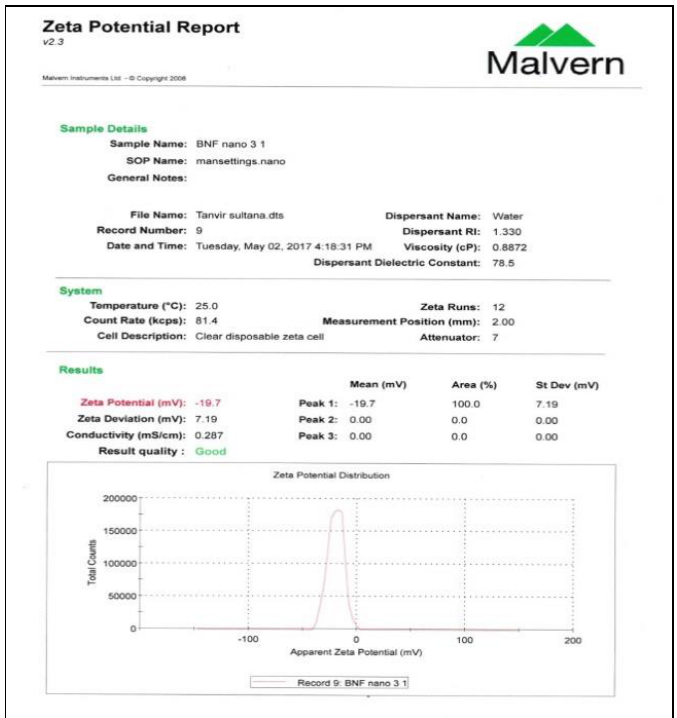
Figure A4. Zeta Potential Reports (sonicated nano cellulose).